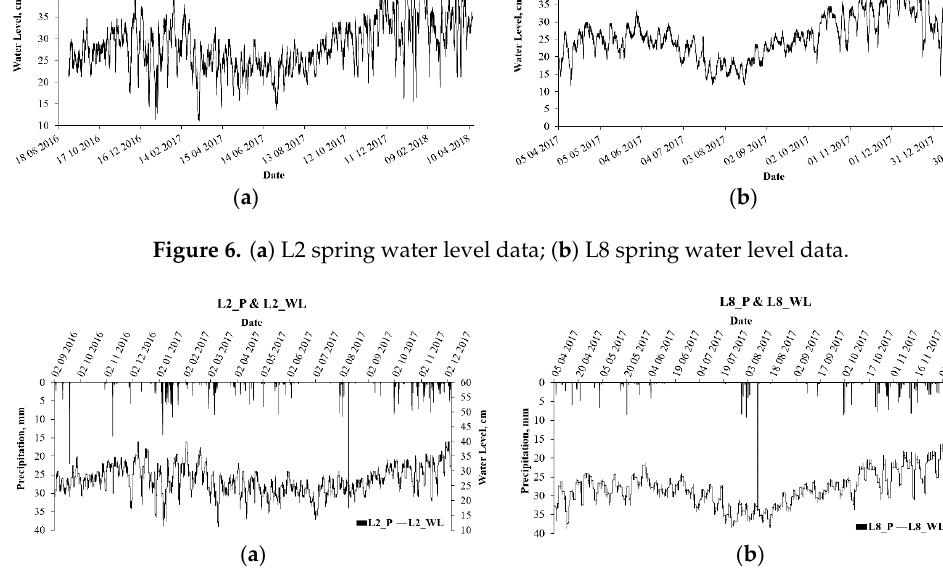
Figure 7. ( a ) L2 spring water level and the precipitation data used for the analyses; ( b ) L8 spring water level and the precipitation data used for the analyses.